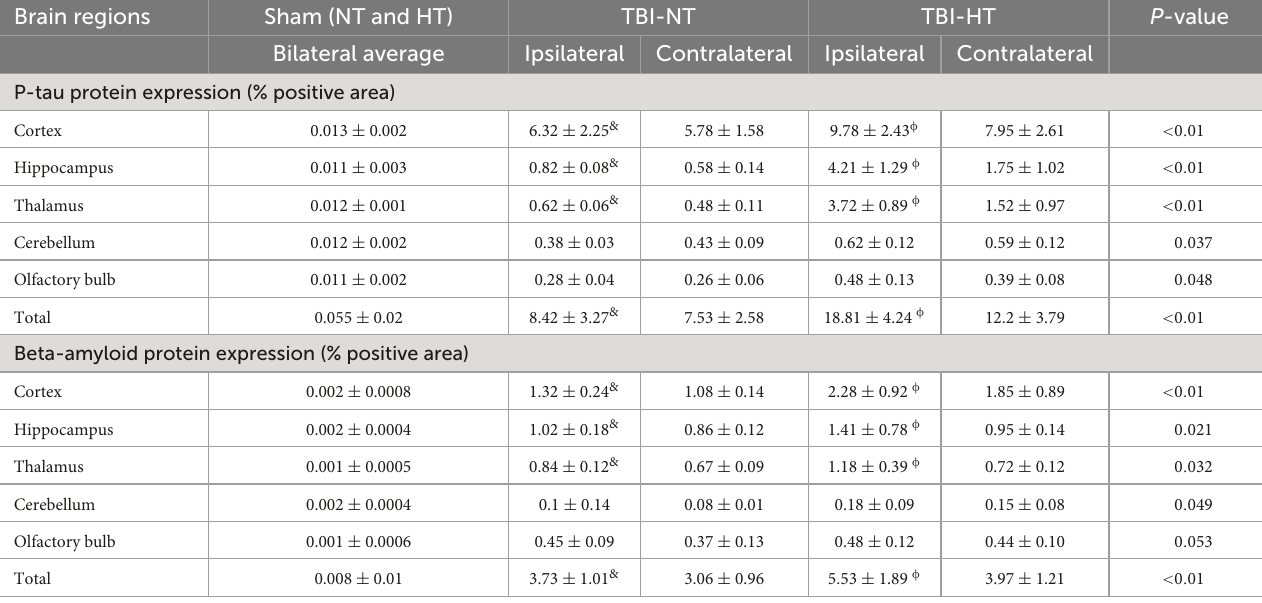
TABLE 2 Quantitative results of p-tau and beta-amyloid protein expression in TBI with hypothermia or normothermia. Brain regions Sham (NT and